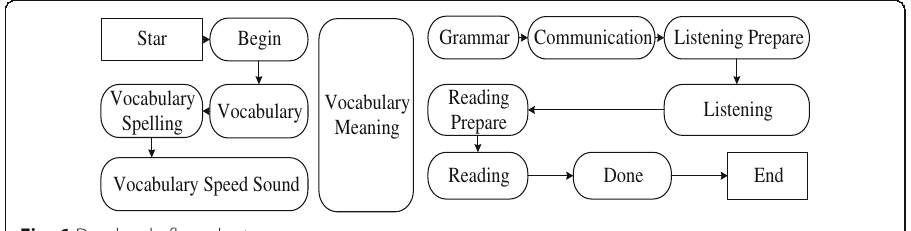
Fig. 6 Drools rule flow chart